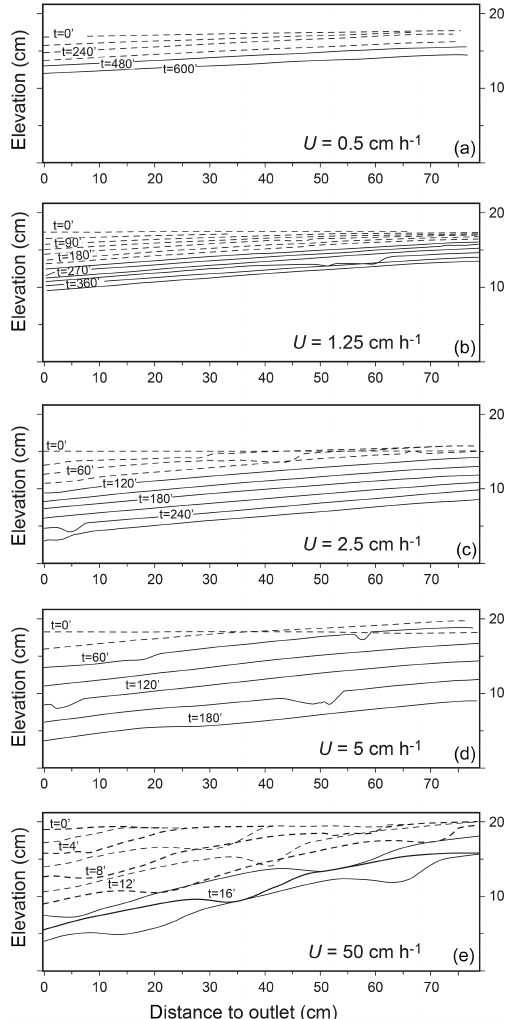
Figure 6. Evolution of the profile’s bed surface elevation as a func- tion of the base-level fall rate (see also Fig. 7a). The bed surface can be either the bedrock or the alluvium surface. Note that the amount of knickpoint increases with base-level fall